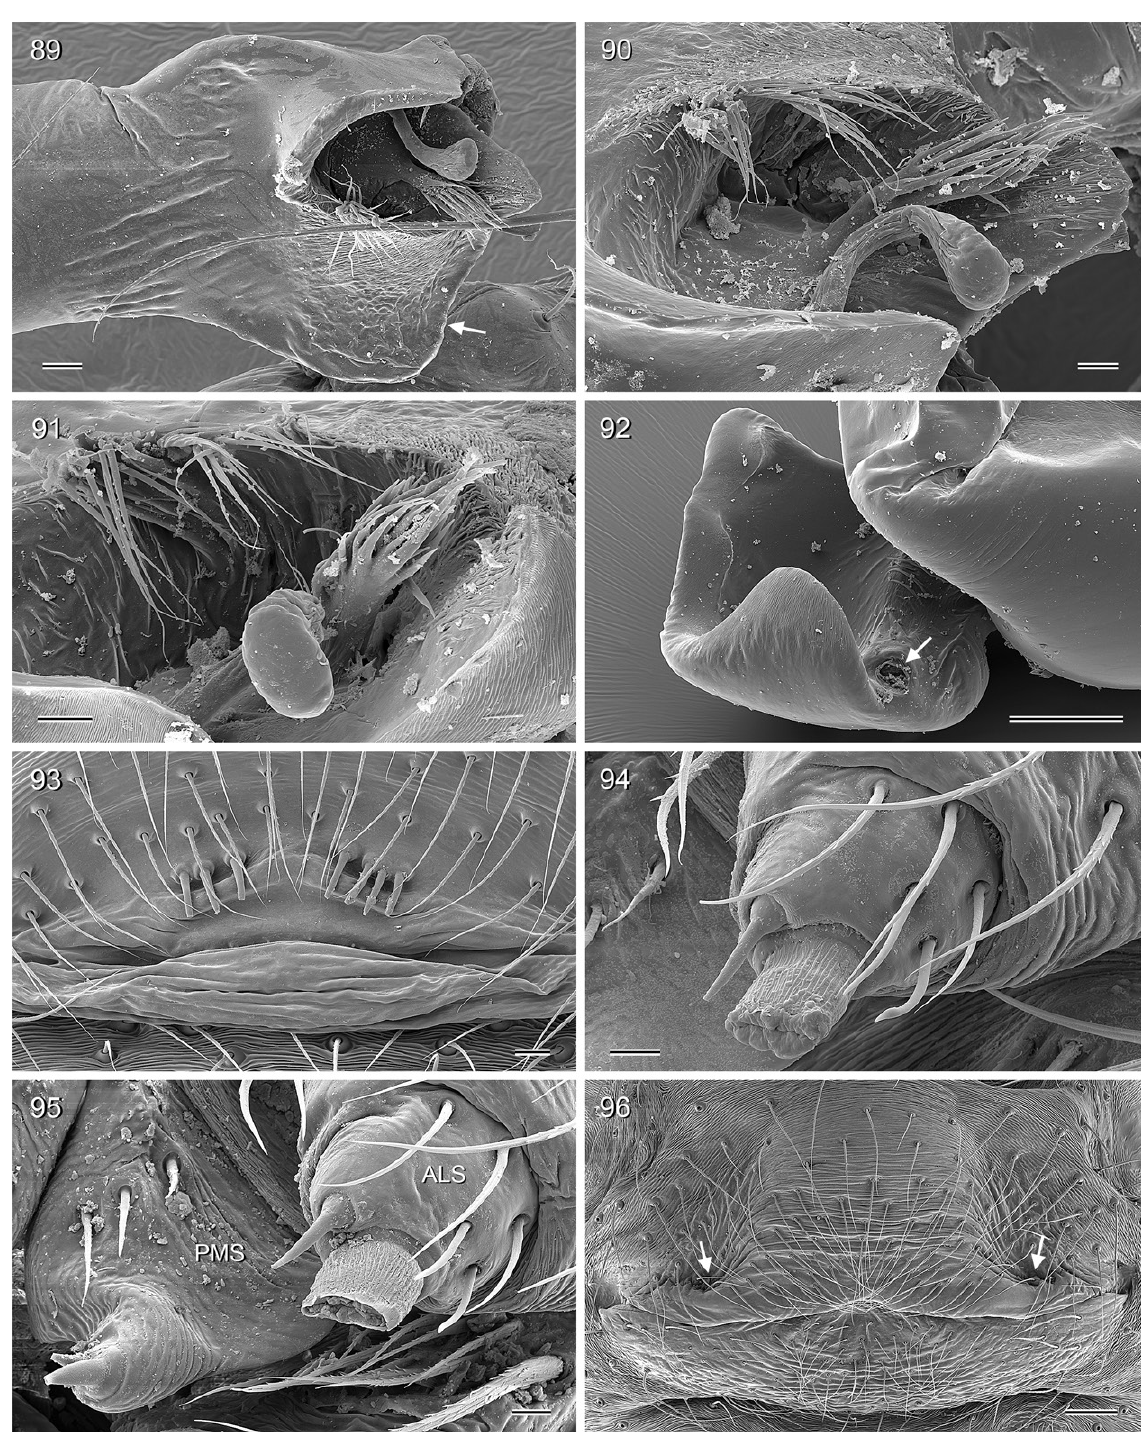
Figs 89–96. Holocnemus reini (C. Koch, 1873) comb. nov.; male and female from Morocco, near Tilamizene (ZFMK Ar 22319). 89–91 . Tips of right (89) and left (90–91) procursi, retrolateral and slightly distal views; arrow: retrolateral membrane. 92 . Left genital bulb, prolateral view; arrow: sperm duct opening. 93 . Male gonopore. 94 . Male ALS. 95 . Female spinnerets. 96 . Epigynum; arrows: pockets. Scale bars: 89, 93 = 20 µm; 90–91, 94–95 = 10 µm; 92, 96 = 100